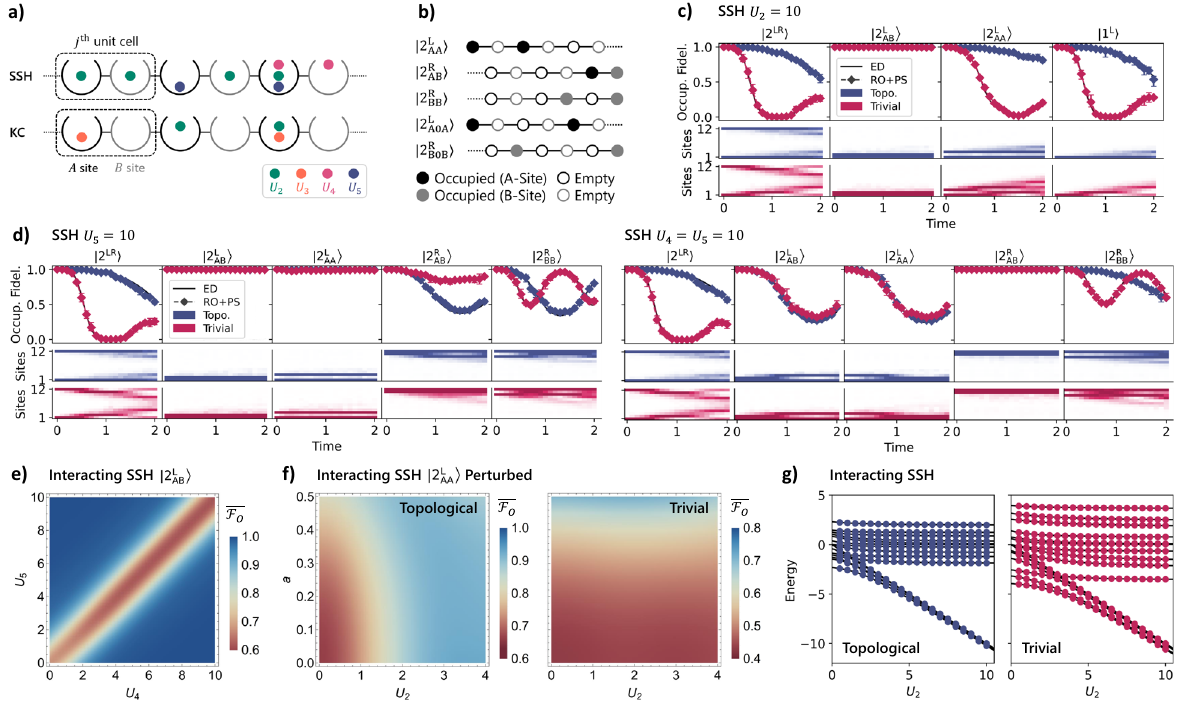
Fig. 3 Stabilizing 2-fermion states in the interacting SSH model. a Schematic illustration of the 2-particle Hubbard interaction terms H SSH and H KC . b The various 2-fermion initial boundary states that we dynamically evolve. They are named according to the sublattice occupancy of int the two fermions — superscripts indicates the edges (left/right) the particles reside in, while subscripts indicate the occupied sublattices. c – d Time-evolution results for 2-fermion initial states on H SSH only, while either AB states are preferentially stabilized when U 5 ≠ 0 only and U 4 ≈ U 5 . In addition, the left (AA) boundary state is stable when U 5 ≠ 0. e In the U 4 - U 5 parameter space, having U 4 ≈ U 5 minimizes average occupancy fi delity F O of the 2-fermion left boundary state 2 L leading to fastest decay. f The U 2 interaction can stabilize the perturbed state are topologically protected. This stabilization works only in the topological phase. g IQPE-obtained 2-fermion band structure of H SSH additional interaction-induced band appears below, with bandgap increasing linearly with interaction strength. Time-evolution results are for N = 6 unit cells ( n = 12 qubits), with error bars obtained from repeated experiments; band structure results are on n = 7 qubits, one of which is an ancilla; error bars smaller than plot markers. See Table 2 for detailed parameter speci fi